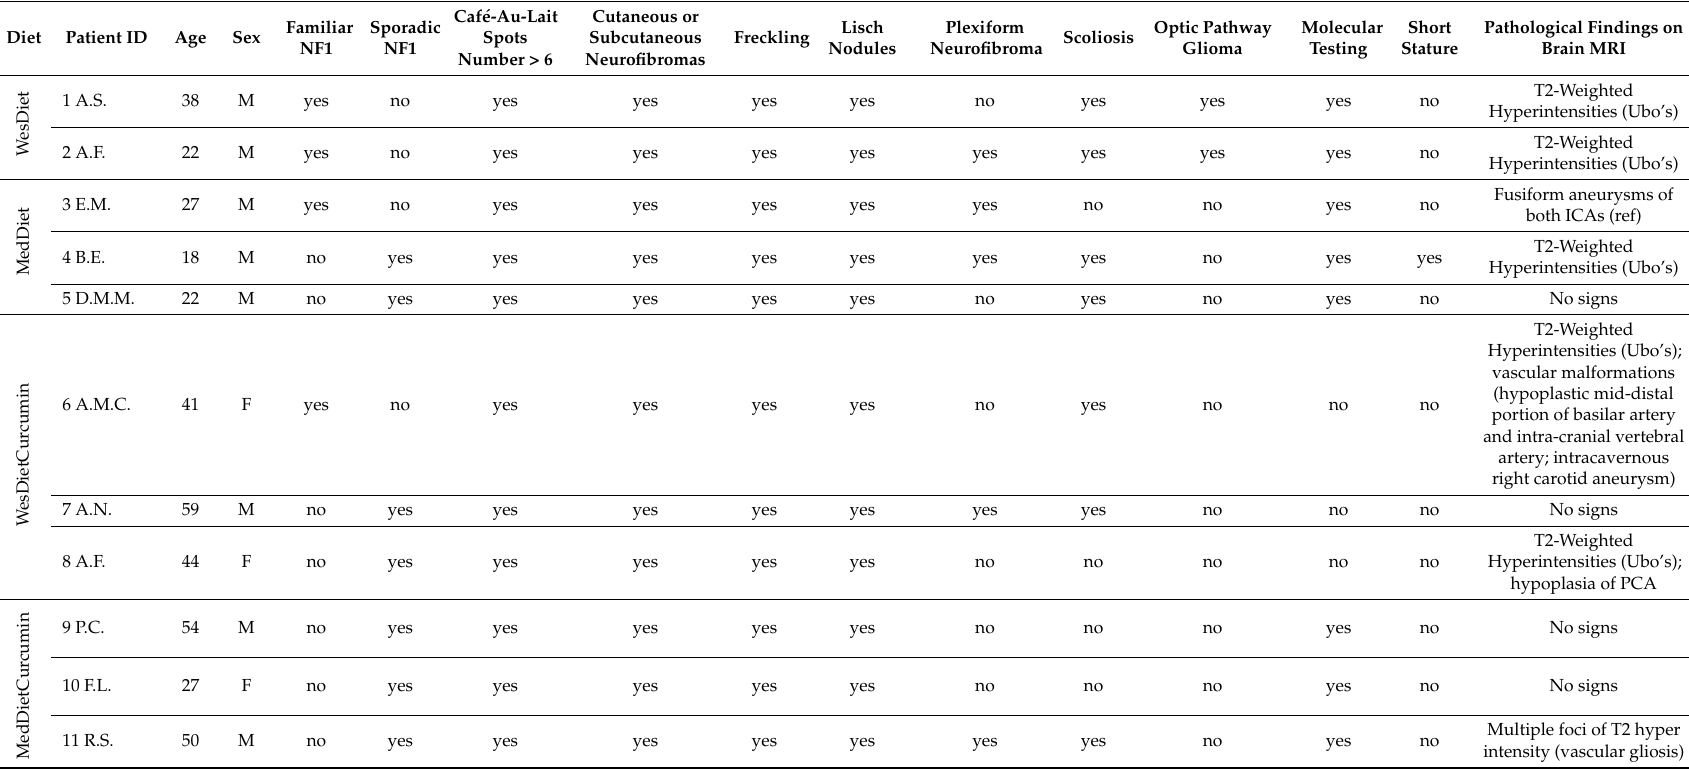
Table 1. NF1 patient